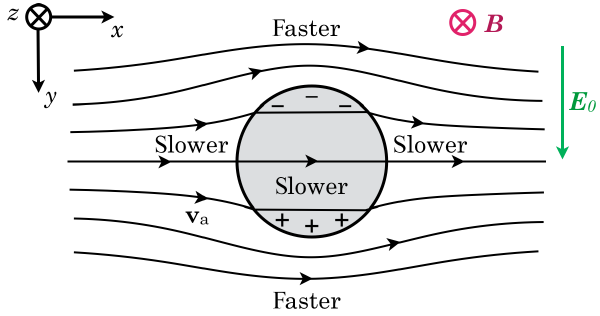
Figure 3. The polarisation of the patch in Fig. 2 establishes a dipole disturbance in the E × B drift. Note that plasma flows through the patch: while the density enhancement should retain its circular shape, the constituent ions are transient.